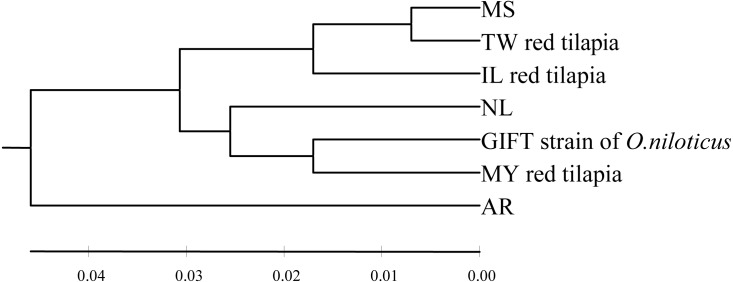
The UPGMA tree based on the D-loop sequences of seven tilapia populations.The numbers above the scale line indicate the K2P genetic distances among populations.